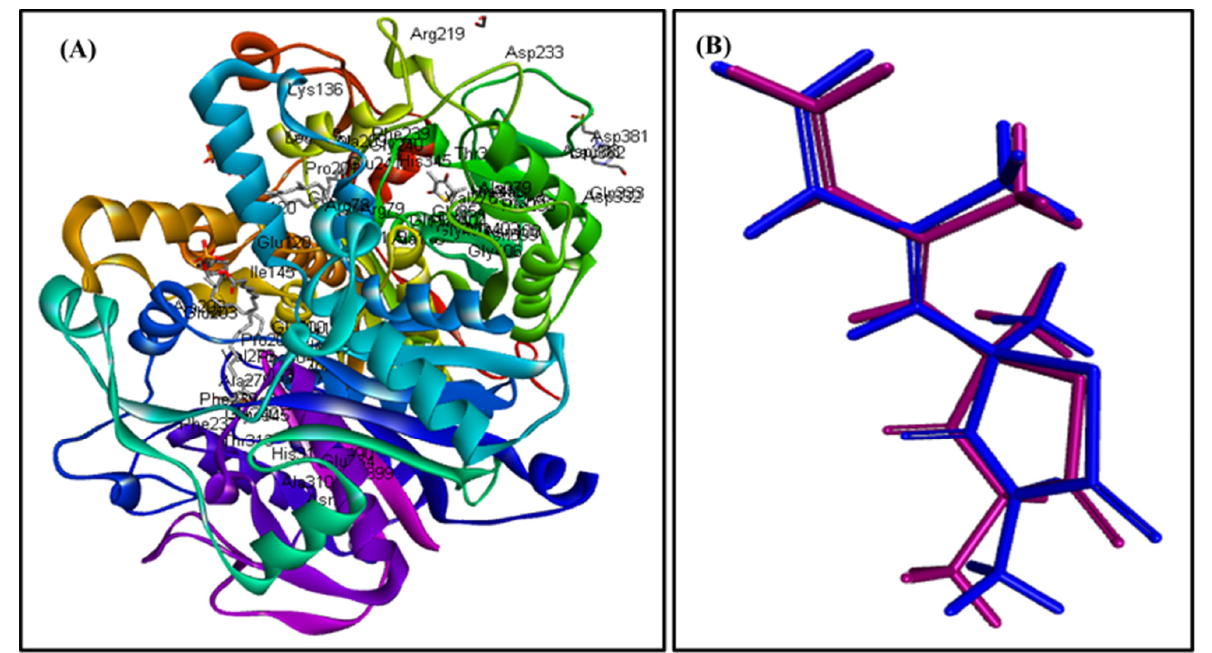
Figure 7. MTB C171Q receptor KasA inhibitor ribbon structure ( A ); validation of the docking experiment ( B ).